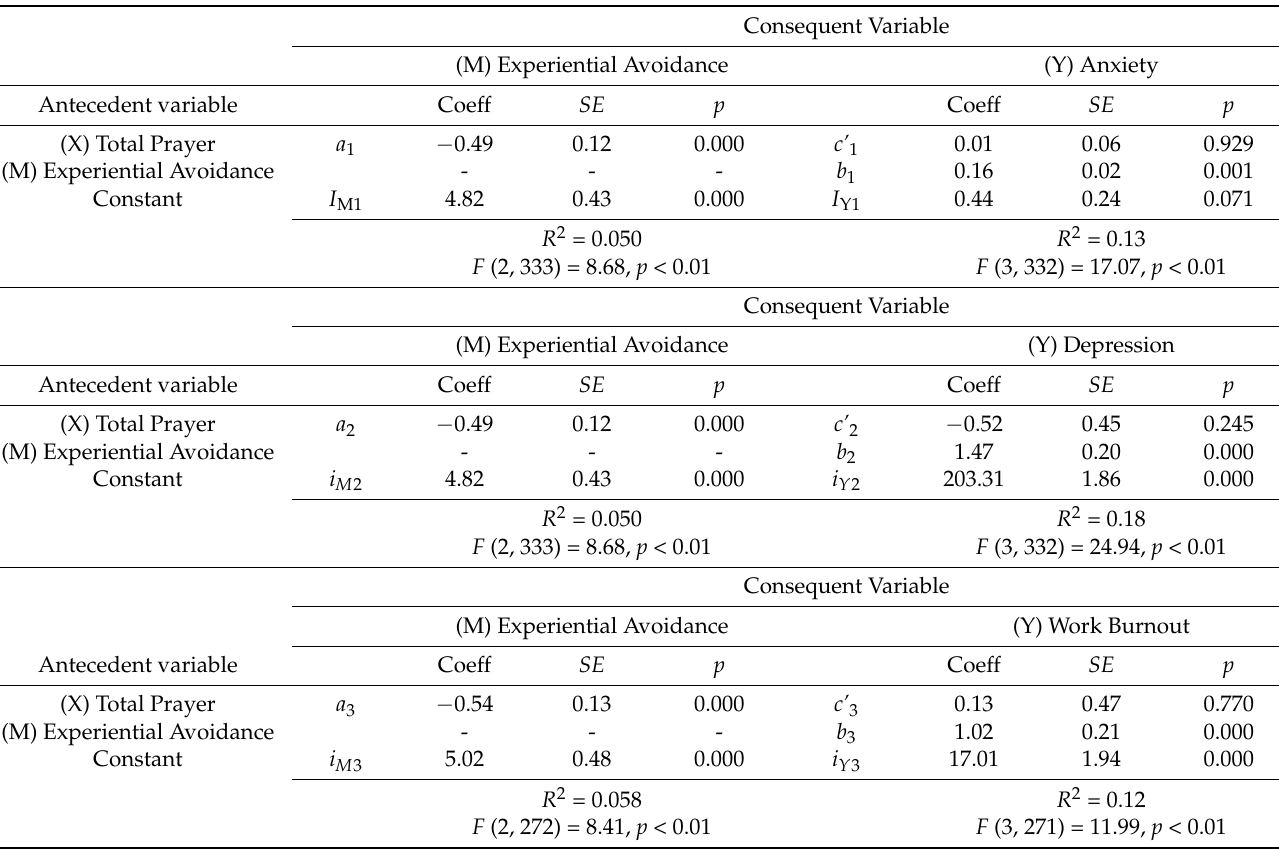
Table 3. Regression models involving total prayer, experiential avoidance and mental health symptoms.